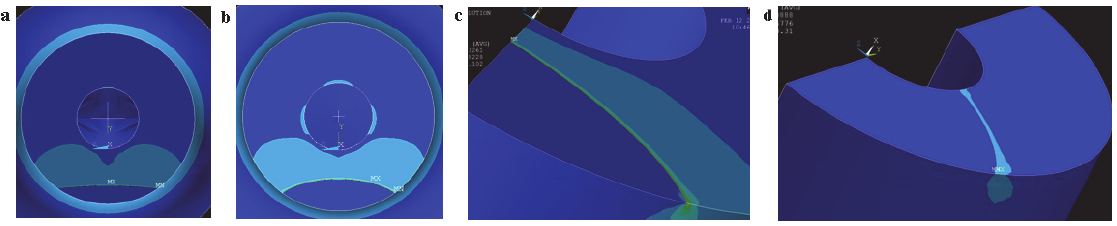
Figure 7: FEM crack front geometry: initial (a), intermediate (b, c), final